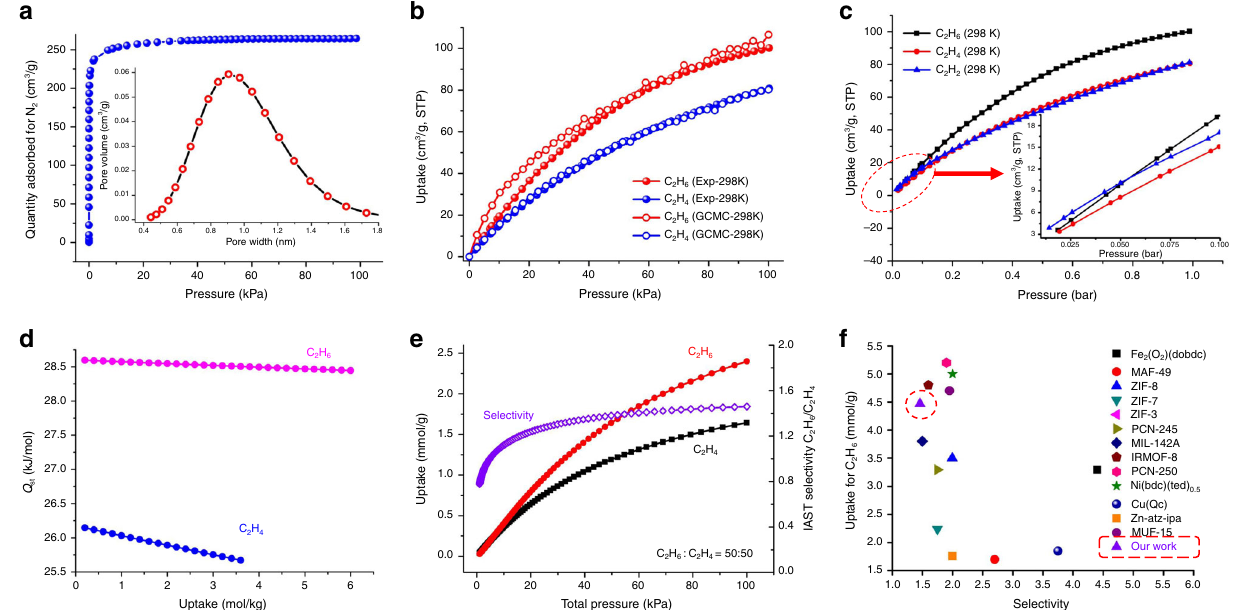
Fig. 4 The adsorption and separation data of Azole-Th-1. a The N 2 adsorption at 77 K with the insert of the distribution of pore size. b The adsorption isotherms of C 2 H 6 and C 2 H 4 at 298 K, including experiments and simulations. c Experimental adsorption isotherms of Azole-Th-1 for C 2 H 6 , C 2 H 4 , and C 2 H 2 at 298 K from 0.01 to 1 bar with the insert of enlargement from 0.01 to 0.1 bar. d The adsorption heat enthalpy of C 2 H 6 and C 2 H 4 , calculated from the single-component C 2 H 6 and C 2 H 4 adsorption data at 298 and 273 K. e Predicted mixture adsorption isotherms and selectivity of Azole-Th-1 by IAST method for a 50/50 C 2 H 6 /C 2 H 4 mixture at 298 K. f A comparison in selectivity and C 2 H 6 adsorption capacity at 298 K and 1 bar between the reported top- performing porous adsorbents for C 2 H 6 /C 2 H 4 separation and our MOF. The purple triangle is our MOF. Source data are provided as a Source Data fi le. conditions is 81.1 cm 3 g − 1 , obviously, less than C 2 H 6 about 20 cm 3 g − 1 . Hence, selective adsorption of C 2 H 6 over C 2 H 4 is suggested. To estimate the adsorption selectivity, we employed the ideal adsorption solution theory (IAST) 66 to analyze the experimental isotherm data, using composition of 50:50/10:90/ 1:15 C 2 H 6 /C 2 H 4 , as shown in Fig. 4e and Supplementary Fig. 8. The selectivity of C 2 H 6 over C 2 H 4 was up to 1.46 at room